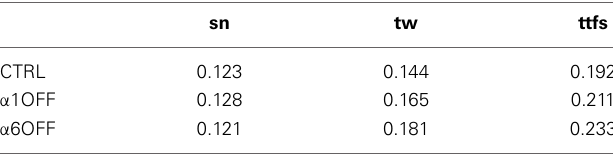
Table 4 | Coding fraction of number of spikes ( sn) , time window ( tw) and time to first spike ( ttfs) was relatively small demonstrating a remarkable redundancy in the parameter